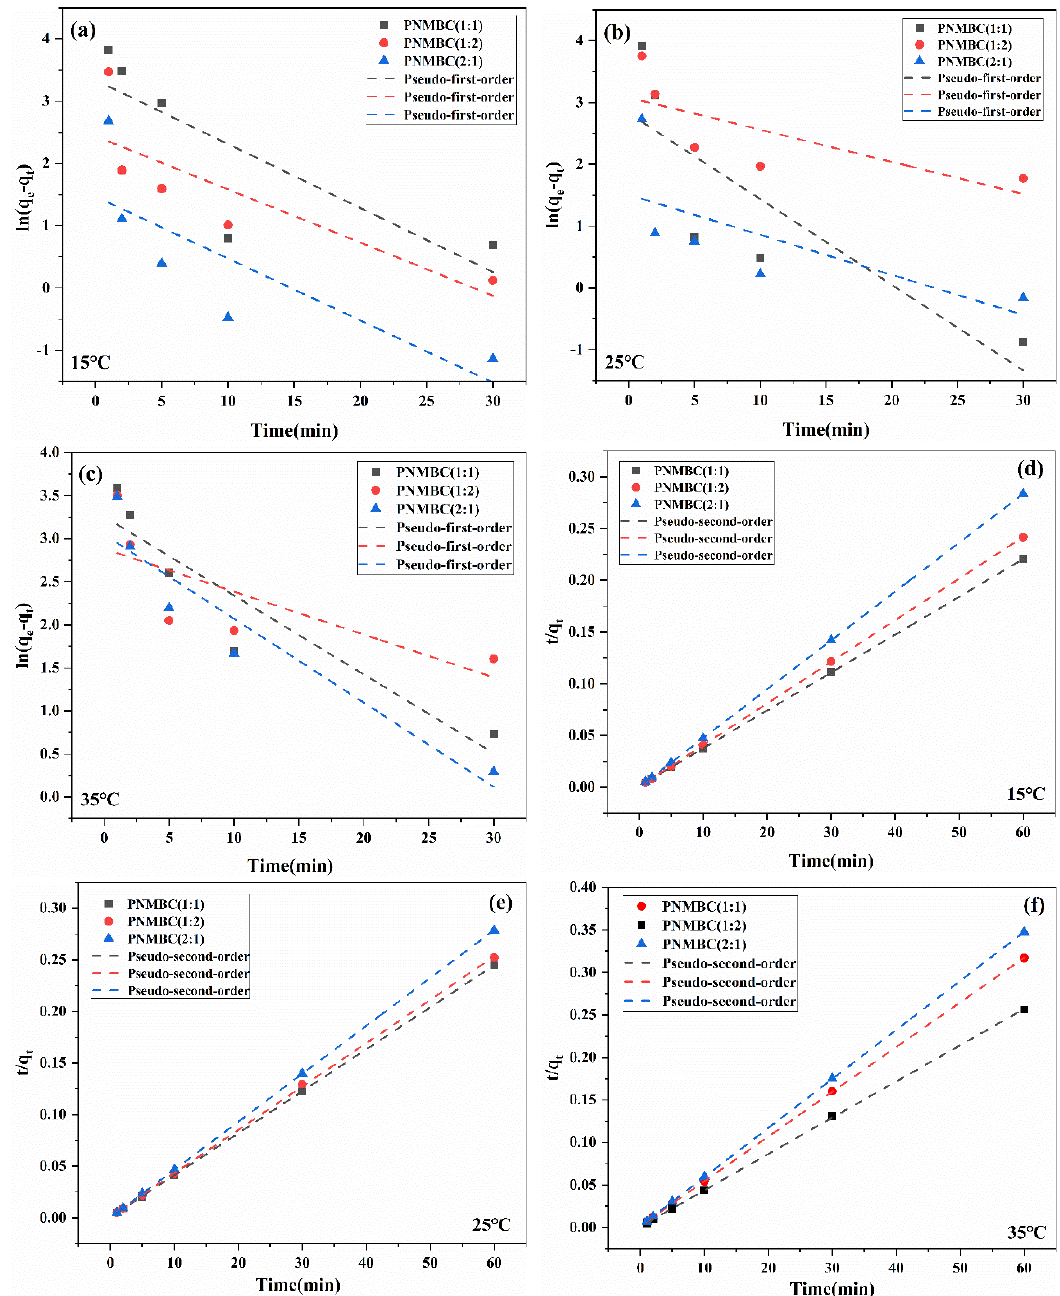
Figure 12. Kinetic fitted curves for Cu( Ⅱ ) adsorption by TOCN – PEI:MB (1:1, 1:2, and 2:1): ( a – c ) pseudo-first-order and ( d – f ) pseudo-second-order. Table 3. Kinetic fitting parameters of PNMBC for Cu( Ⅱ ) adsorption.